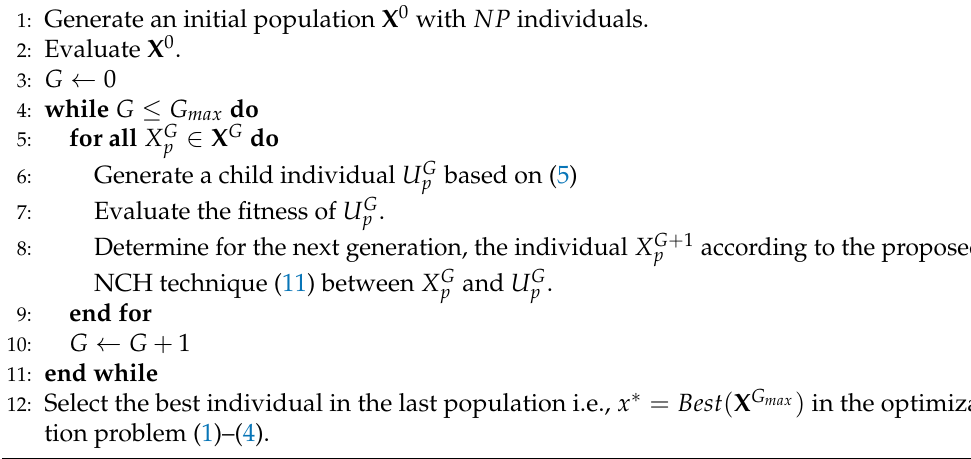
Algorithm 1 Pseudo-code of the DE/RAND/1/BIN with the inclusion of the NCH tech- nique